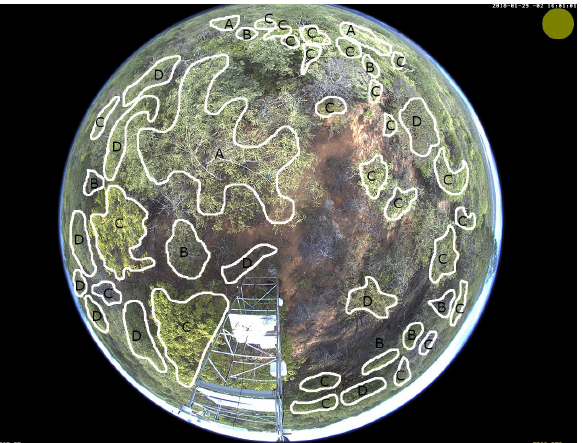
Figure 3. Example of a hemispherical image used for the proximal remote sensing phenological analyses at the study site, PE-Brazil. The areas selected in white represent tree crowns of individuals from four species: A, Anadenanthera colubrina ; B, Aspidosperma pyrifolium ; C, Cenostigma nordestinum and D, Commiphora leptophloeos .